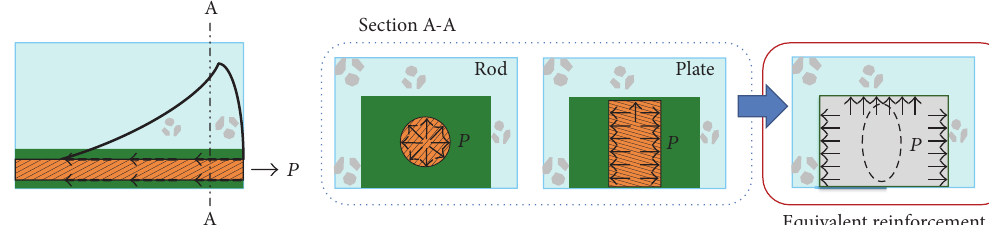
Figure 2: Concept of equivalent section.